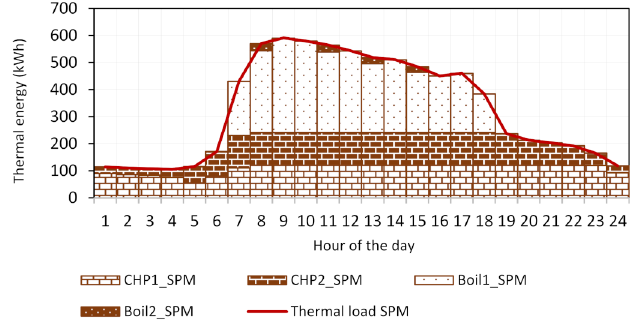
Figure 24. Thermal energy balance of the SPM for space heating and domestic hot water obtained with stochastic environmental optimization for the representative winter day.